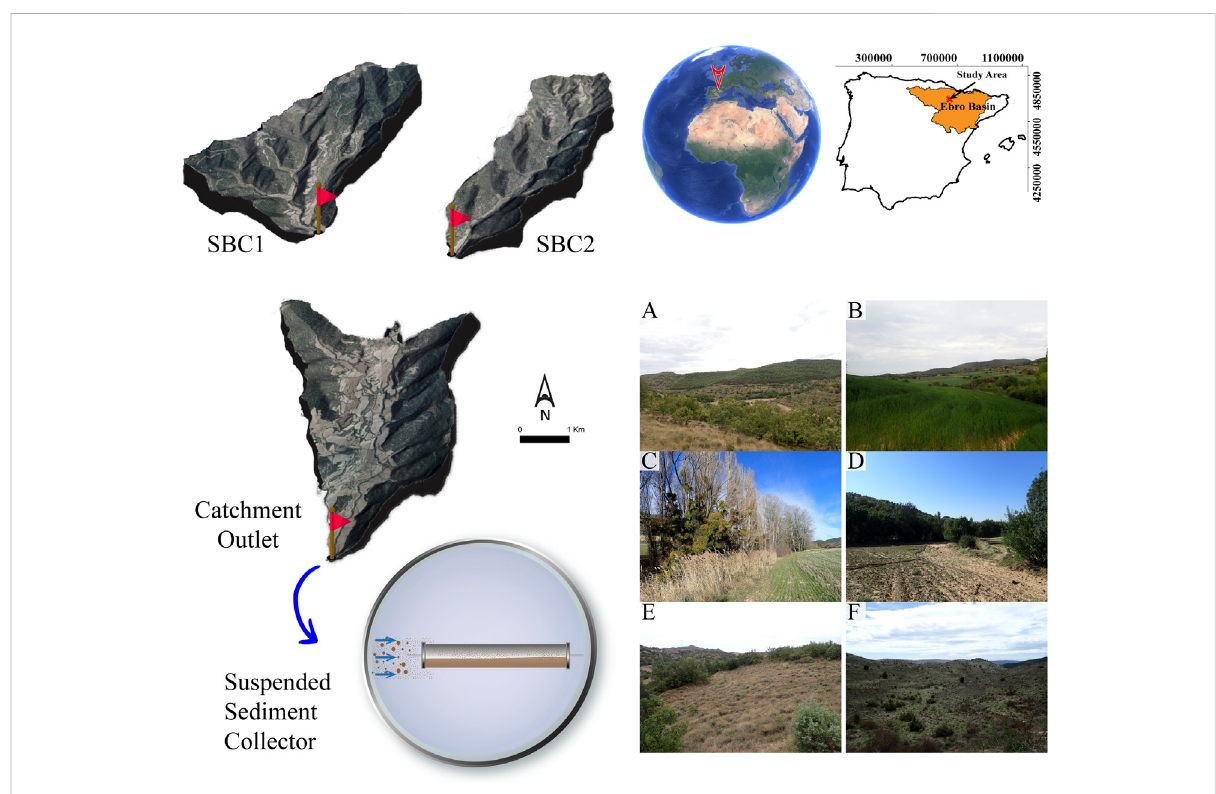
FIGURE 1 Location of the Barués catchment in the central part of the Ebro Basin (NE Spain). A 3D map of the three studied sub-catchments, SBC1, SBC2, and the catchment outlet (CO). (A – F) Images of the main land covers: (A) pine afforestation and Mediterranean open forest (MF); (B) cropland (CF) andriverbankvegetation(RB)inthemainstreamintheSBC3/catchmentoutlet; (C) riverbankvegetationandwheatcroplandatits fi rstgrowthstages; (D) eroded cropland exporting sediment to the stream; (E) scrubland in abandoned cropland; and (F) headwaters abandoned